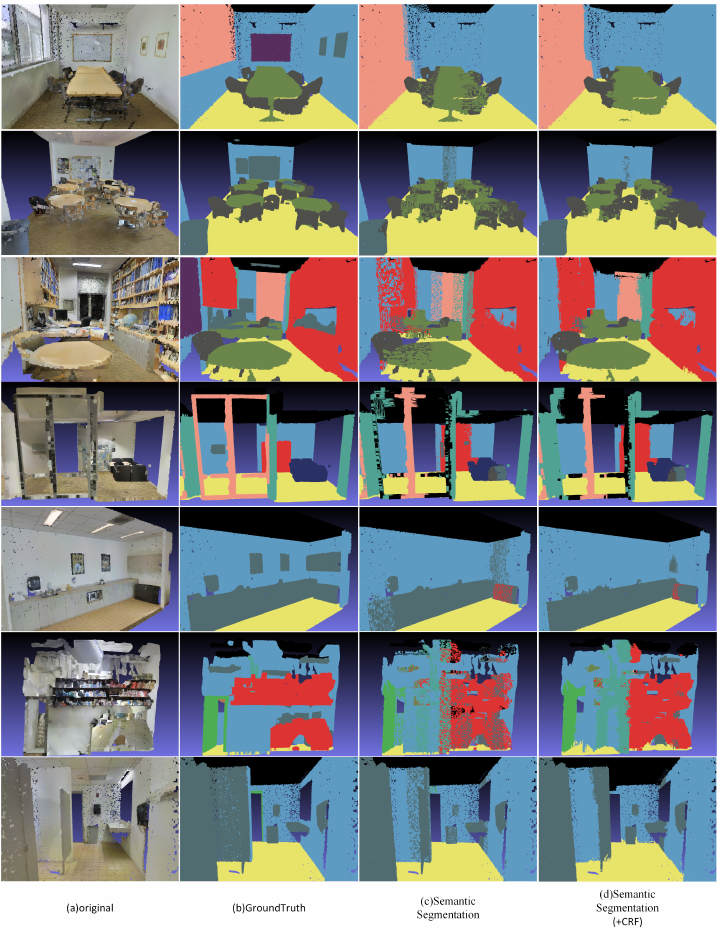
Figure 7. The semantic segmentation results of the proposed method based on S3DIS data set [36]. Table 2 shown a comparison results of semantic segmentation based on metric:mIoU,